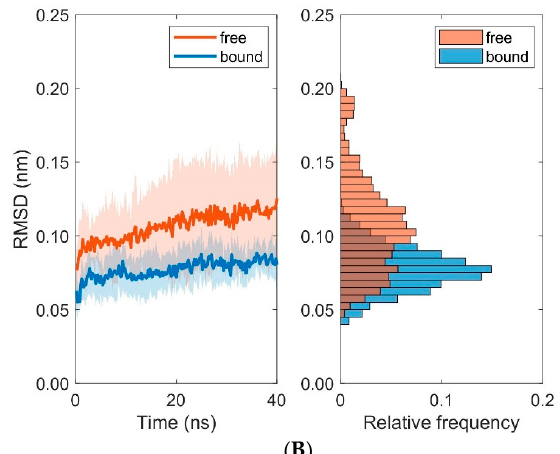
Figure 9. Time course and distribution of RMSD-values for domains MHC α 1 ( A ) and MHC α 2 ( B ). Time-series (left panels, mean ± SD) and histograms (right panels) display pooled RMSD-values from ten 40 ns MD simulations each for bound and unbound (free) states.